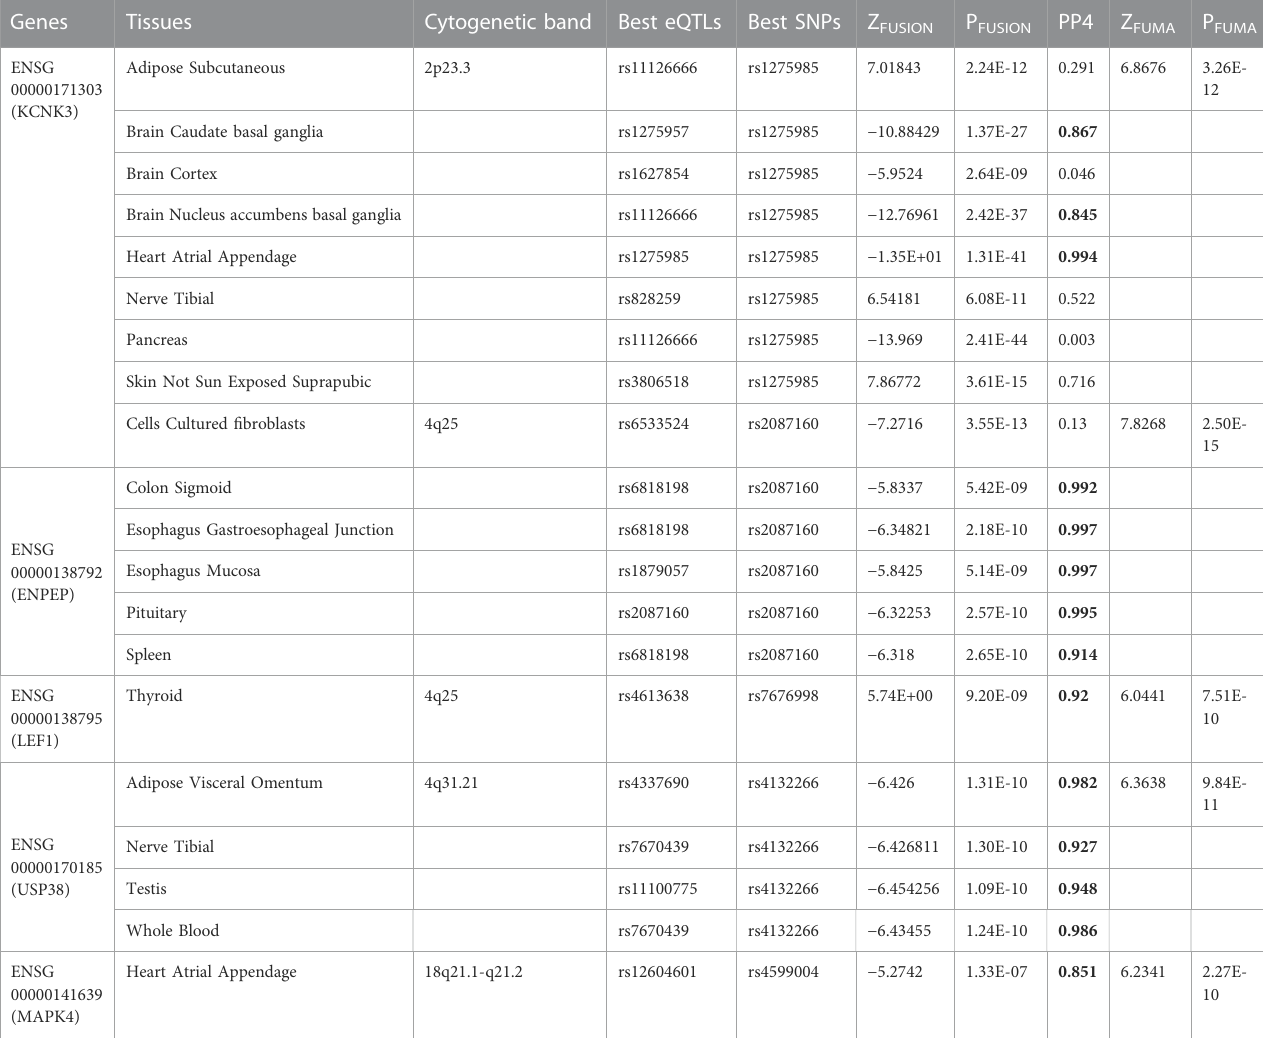
TABLE 2 List of the signi fi cant candidate genes identi fi ed by UTMOST, FUSION and FUMA. Genes